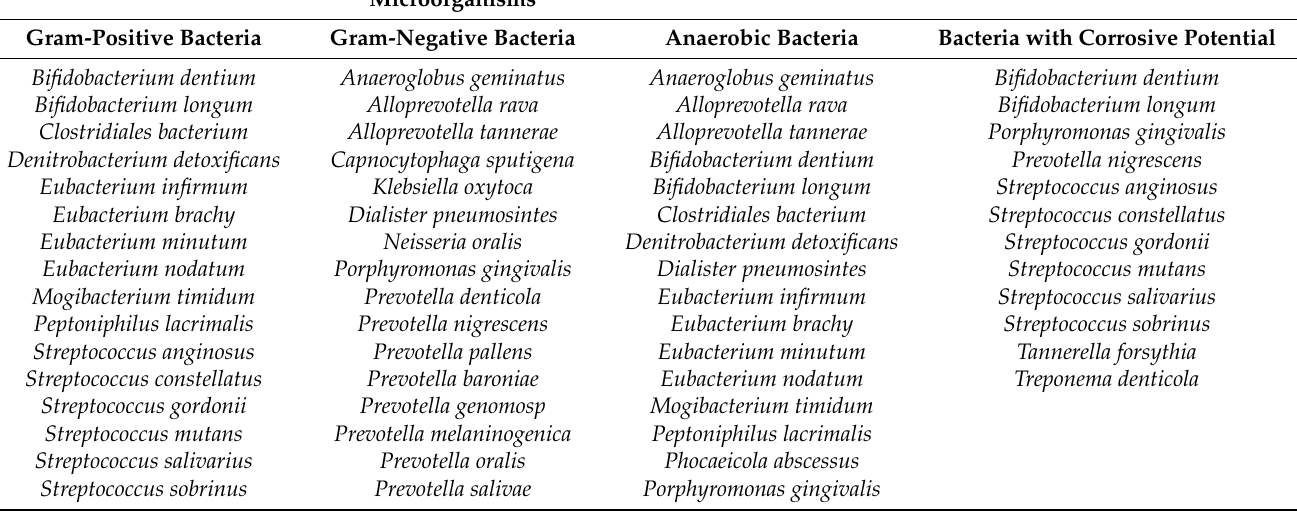
Table 3. Microorganisms breeding and culture-depended under the laboratory conditions isolated from tooth implants of the patients with full-blown peri-implantitis identified to the species by the NGS